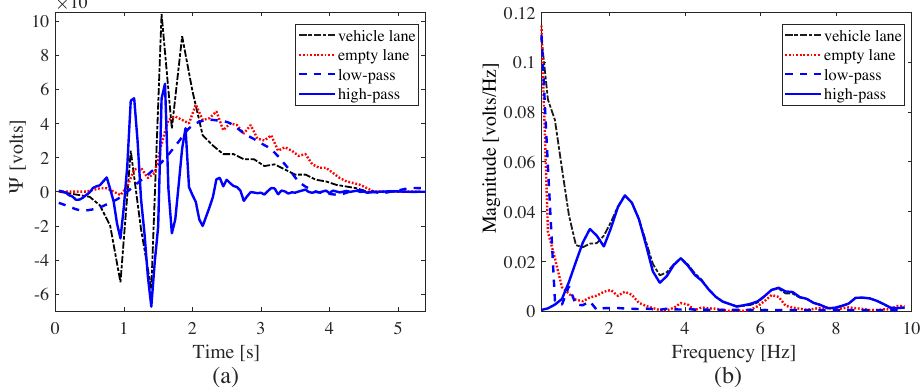
Figure 4. Comparison of low and high frequency components of a typical signal: ( a ) time domain; and ( b ) frequency